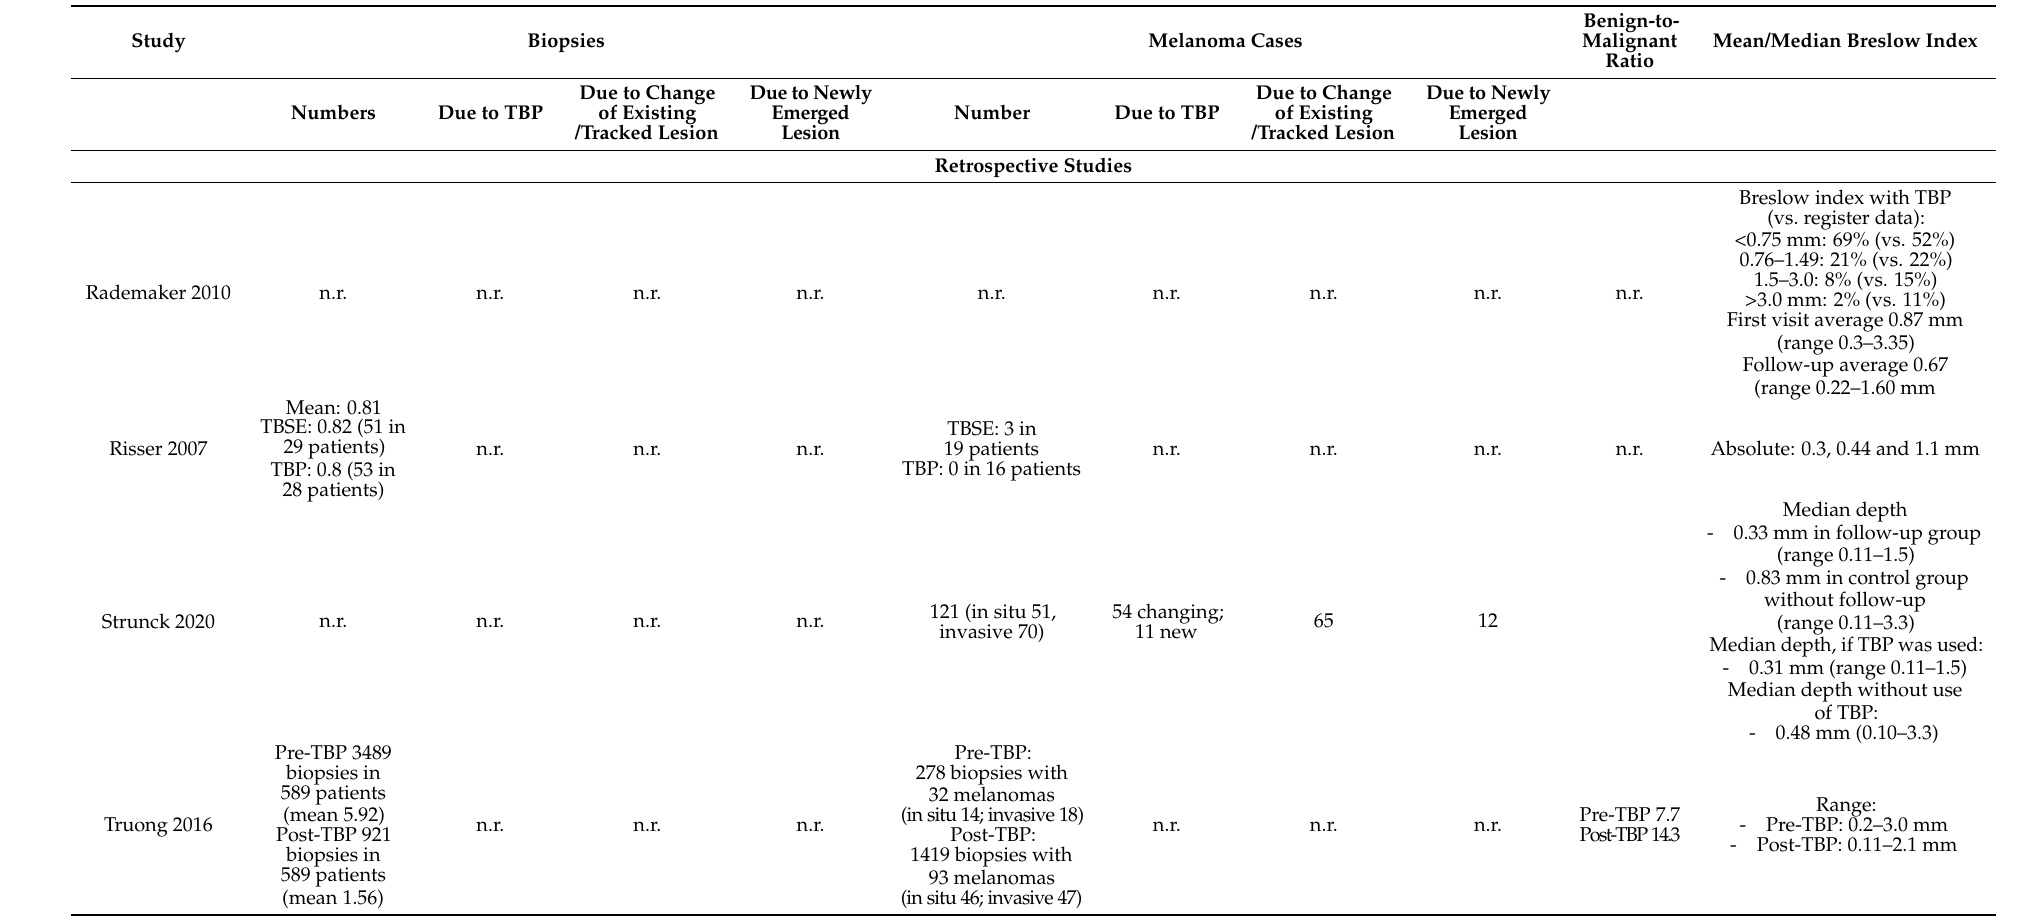
Table 4. Summary of the Outcomes of Interest of the Included Studies with a Comparison of TBP vs.